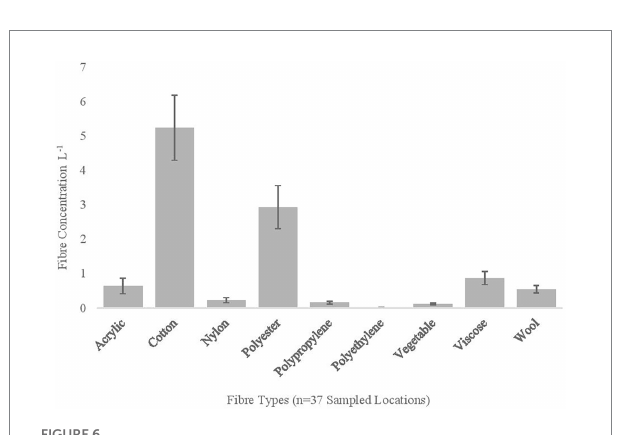
FIGURE 6 Mean fibre concentration of fibre types recovered across sampled